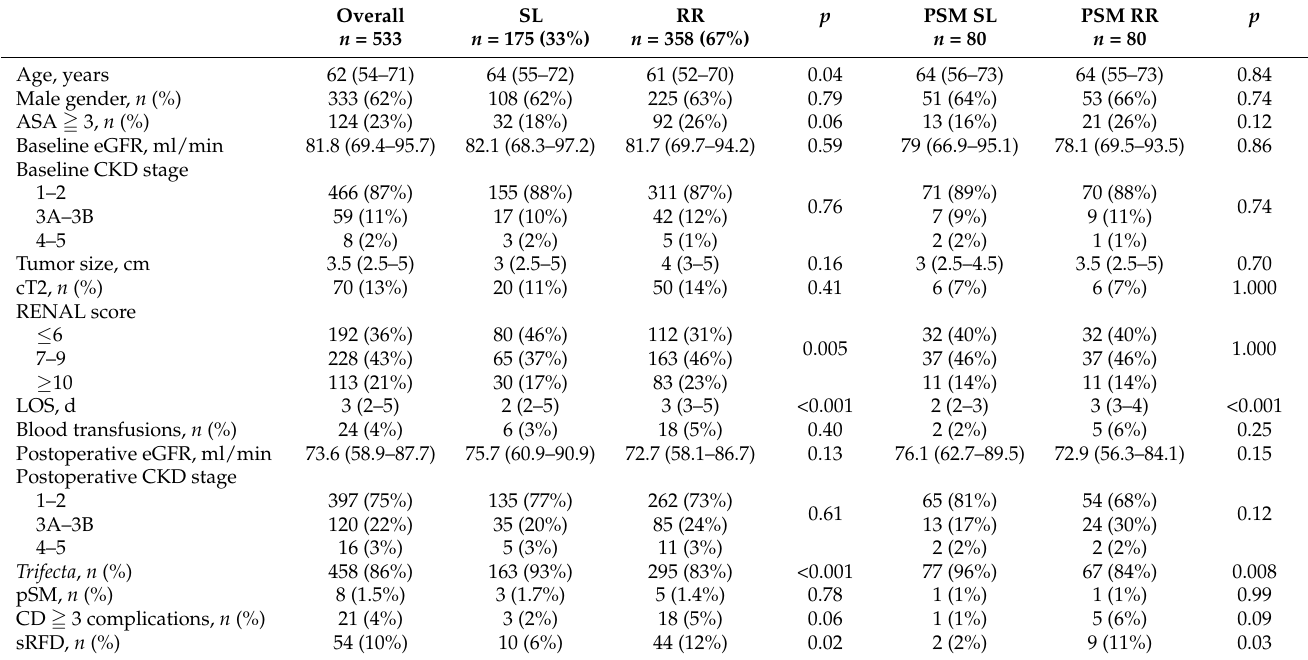
Table 1. Patients’ characteristics and outcomes after